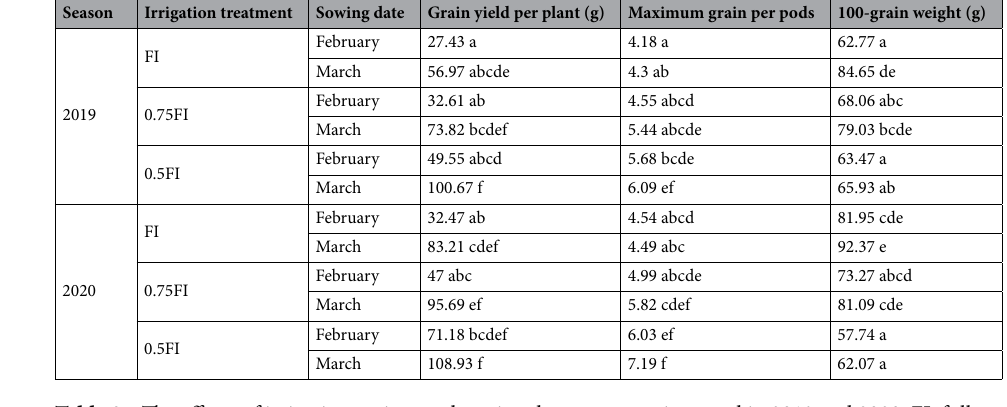
Table 3. The effects of irrigation regime and sowing date on pea traits tested in 2019 and 2020. FI, full irrigation. The data averaged over nitrogen treatments, Means with different letters did differ significantly.